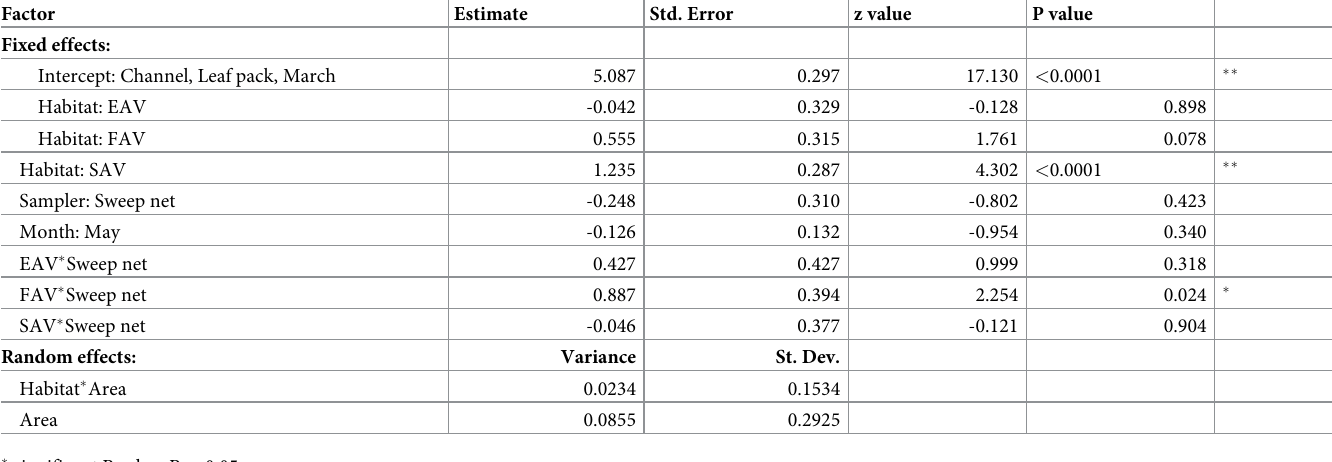
Table 3. Coefficients for the negative binomial mixed model with a log link predicting total invertebrate catch of sweep nets and leaf packs Model: Catch ~ Habi- tat � Sampler + Month + Error(Area/Habitat). Factor Estimate Std. Error